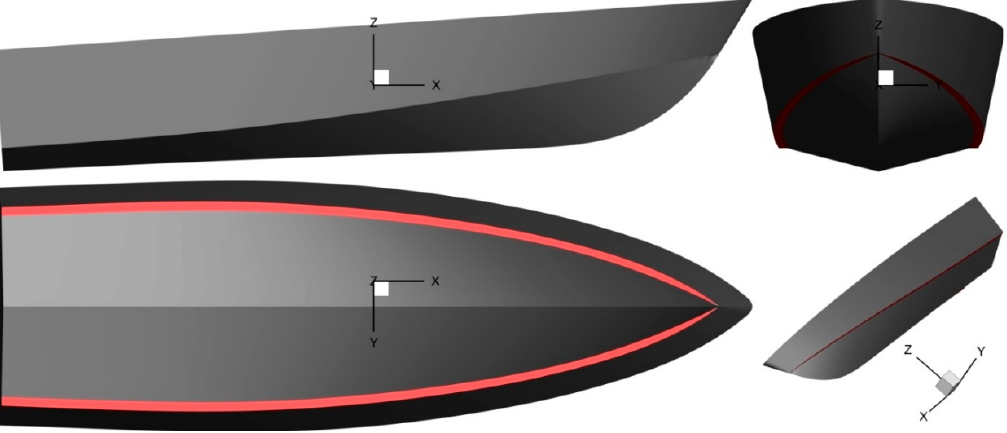
Figure 1. Validation case geometry showing profile, front and bottom views, respectively. Table 1. Validation case dimensions and main